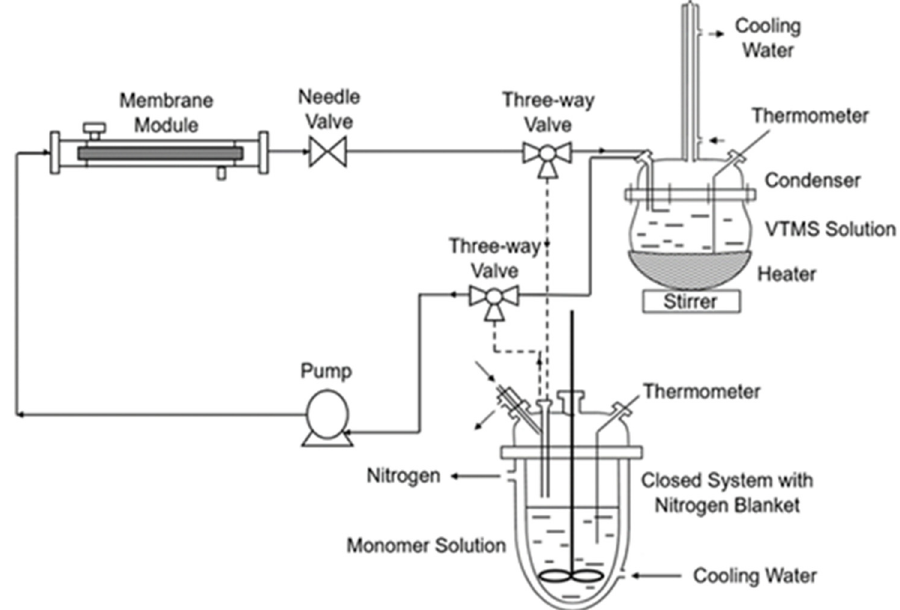
Figure 2. Illustration of the experimental setup for membrane silylation and graft polymerization. Graft polymerization was carried out with the bottom three-way valve directing the monomer solution flow from the monomer reservoir to the membrane module (indicated by the dashed line) and then back to the reservoir via the top three-way valve (following the stream indicated by the dashed line).